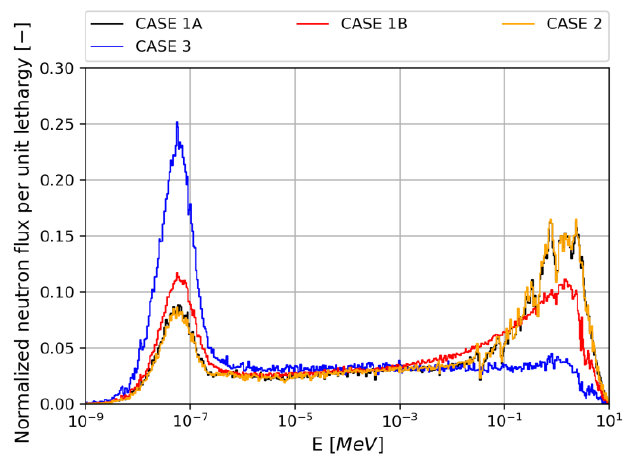
Fig. 4. Neutron flux profile in light water - CASE 1A. The same position of the detectors as in the CASE 2. 7-group structure, ENDF/B-VII.1 [6]